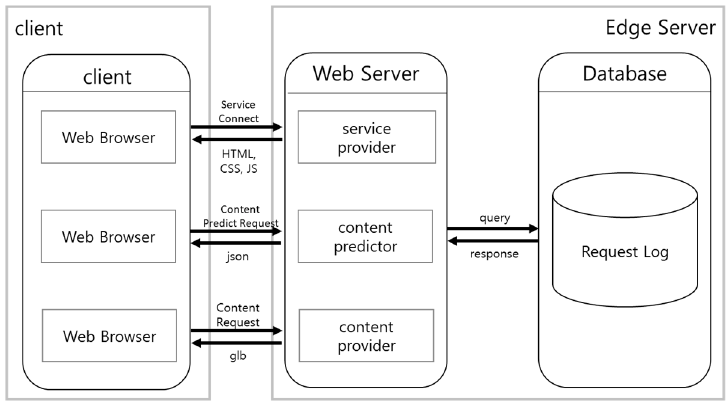
Figure 4. Client and server architecture.